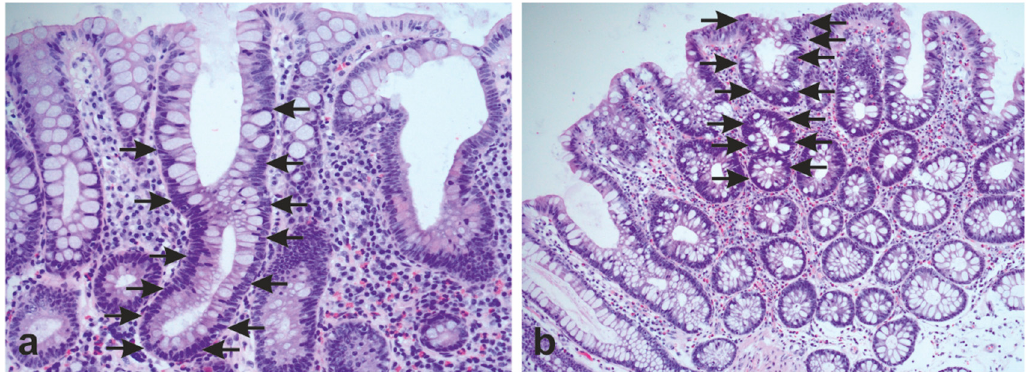
Figure 4. Morphological features of adenomatous polyps in the human large intestine. ( a ) “Bottom-up” morphology characterized by ascending cells with nuclear atypia (arrows indicate atypical cells) and normal plateau. ( b ) “Top-down” morphology with accumulation of atypical cells at the mucosal plateau (arrows indicate atypical cells), but normal cell composition, including goblet cells at the crypt basis. Original magnification: 200×.